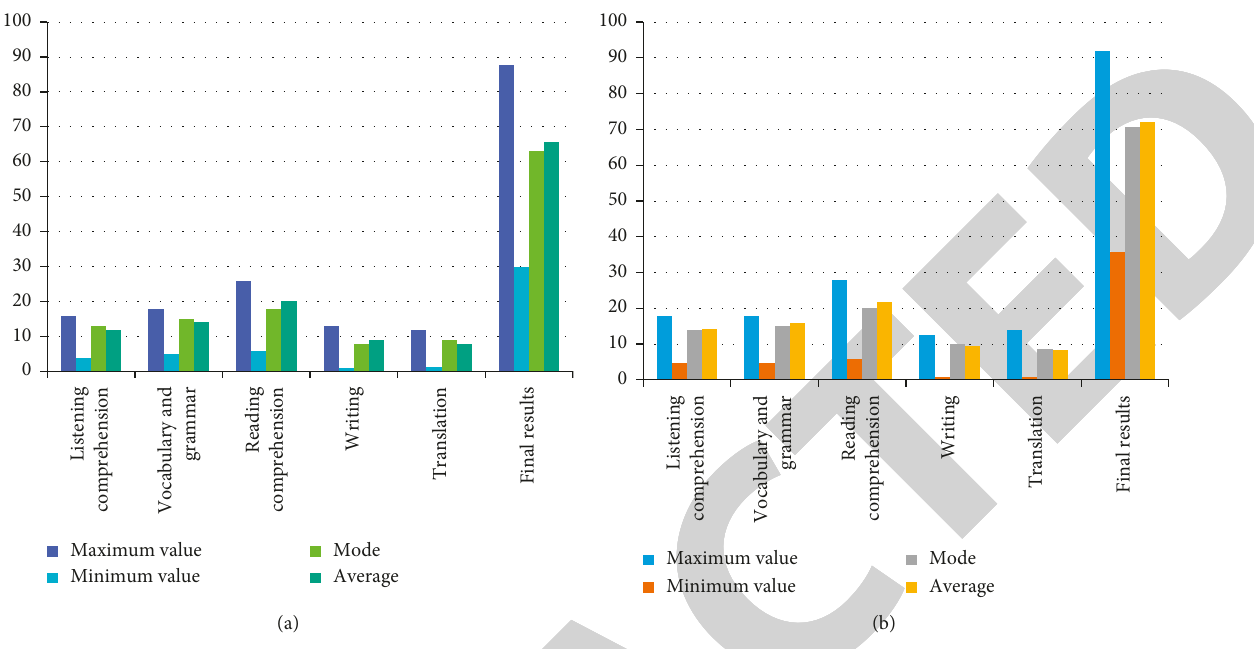
Figure 8: Comparison of English test results. (a) Traditional teaching. (b) Multimedia-assisted